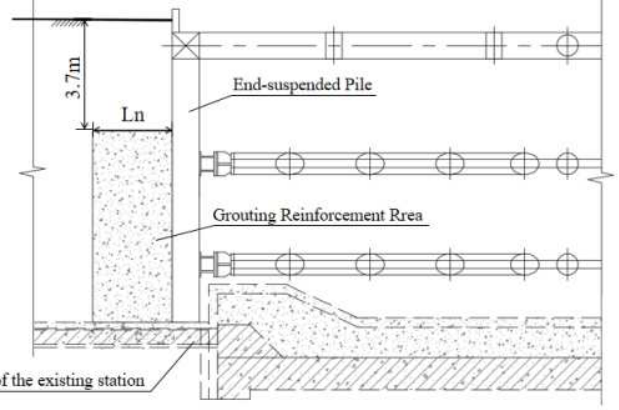
Figure 11. Schematic diagram of grouting reinforcement position.